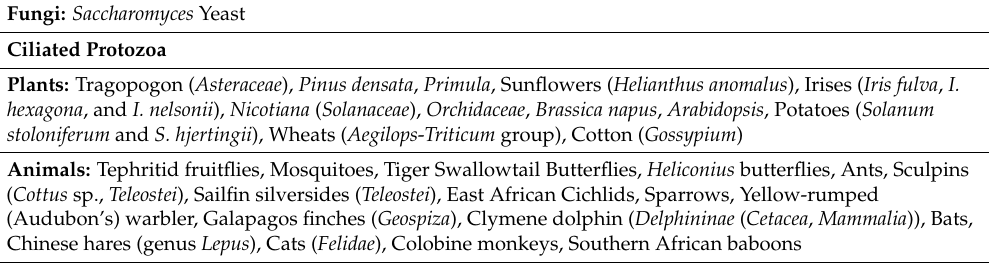
Table 4. Examples of Speciation and Adaptive Radiation Involving Interspecific Hybridization and Changes in Chromosome